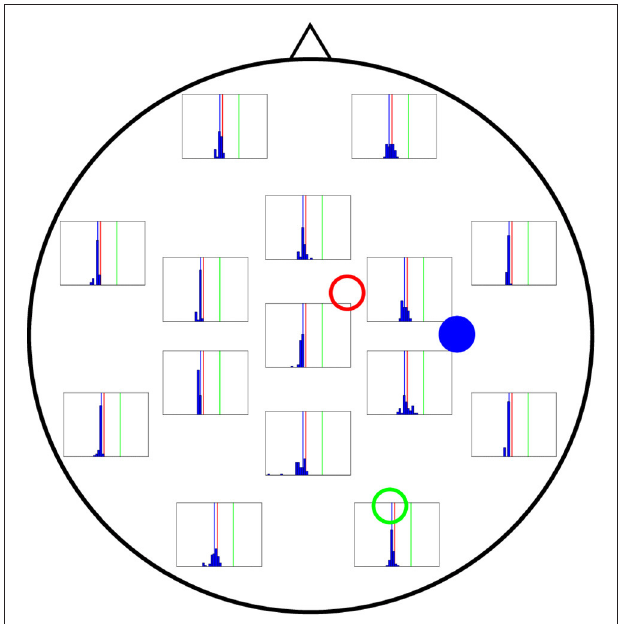
FIGURE 8 | Distribution of 50 realisations of A estimations from a single electrode for cortical column 3 (solid blue circle). As in the two previous figures, the distributions for the electrodes closest to the source (solid blue circle) are narrow, grouping around the correct value ( A 3 Surprisingly, the electrodes in the far left also give rise to narrow distributions.